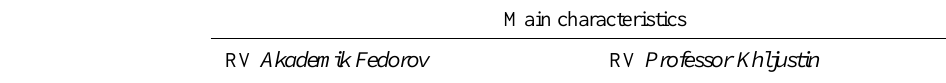
Table 1. Brief characteristics of instruments in aerosol